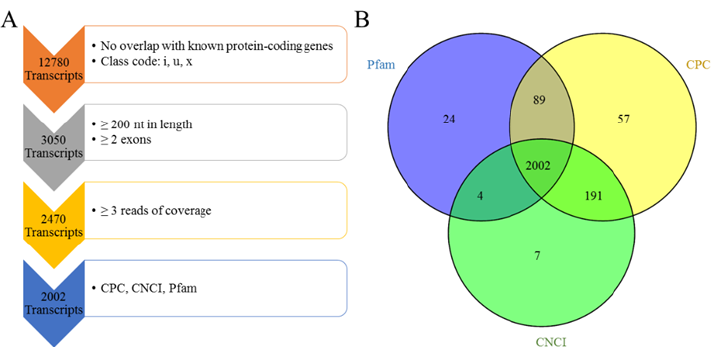
Figure 1. Pipeline for the identification of multiple-exon lncRNA. ( A ) Overview of the stringent filtering pipeline used to identify the resulting 2002 lncRNAs. At each step, the vertical arrow denotes the transcripts that passed the filter and the box denotes the screening conditions. Each step is described in detail in the Methods section. ( B ) The intersection results of CPC, CNCI and Pfam. A total of 2119 lncRNA transcripts were obtained by Pfam, 2339 lncRNA transcripts were obtained by CPC and 2204 lncRNA transcripts were obtained by CNCI. Finally, 2002 lncRNA transcripts were identified from the intersection of the analysis results of CPC, CNCI and